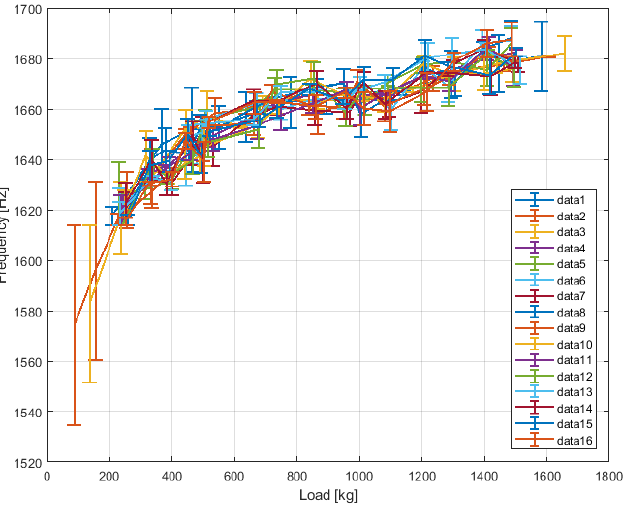
Figure 8. Dependence of the resonance frequency in the function of load for non-sintered sample determined with the use of acoustic emitter.